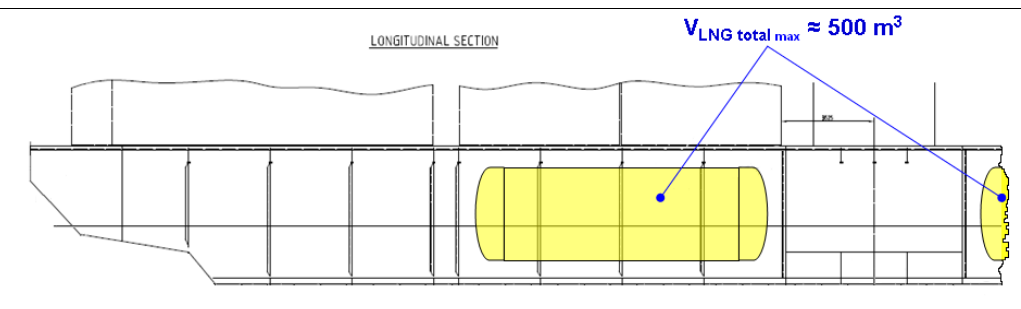
Figure 11: Possible accommodation of LNG tanks on board the Port Feeder Barge